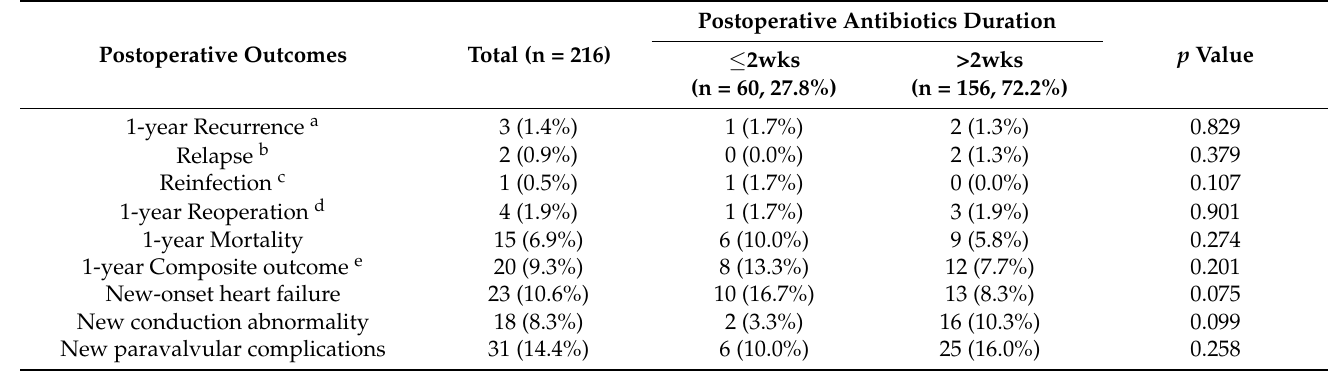
Table 2. Postoperative outcomes in patients with infective endocarditis who underwent valve surgery.